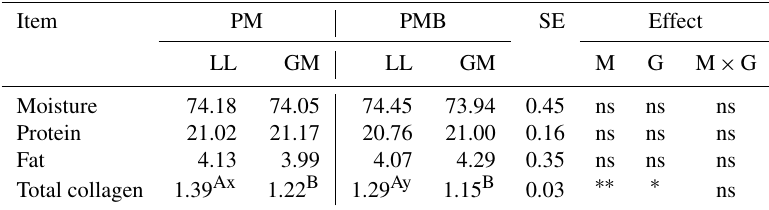
Table 3. The mean values for meat chemical composition for different genotypes and muscles (%). Item PM